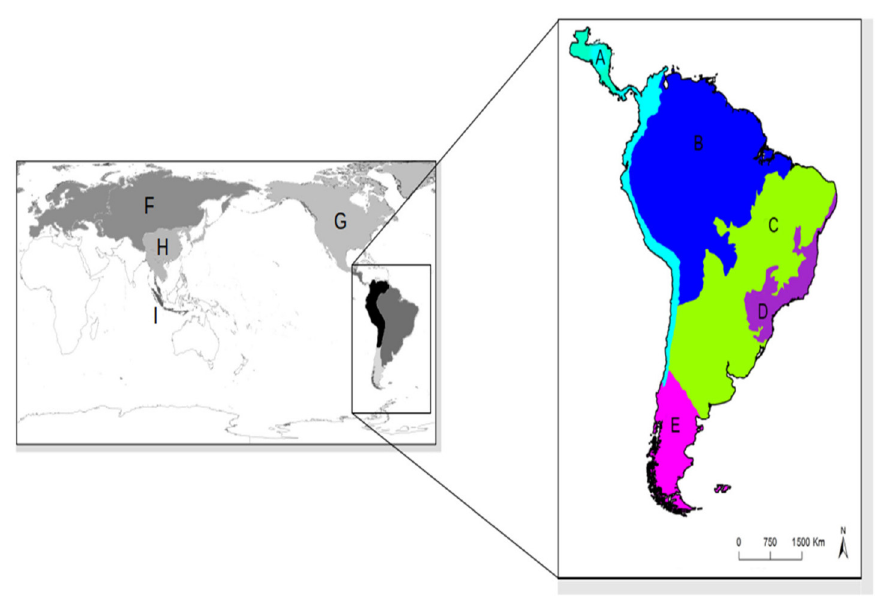
Figure 1. Map of world bumblebee species by region. Left: biogeographic regions of the world defined for bumblebees modified from Willians [7], and right: subdivisions of the Neotropical region modified from Morrone [45]. A—northern and western regions of the Andes (northwestern South America + South American Transition Zone [45]); B—Amazonian region; C—Chaco region; D—Parana region; E—Andean region; F—Palearctic region; G—Nearctic region; H—Oriental region; I–Sumatra region. The Sumatran region was not represented by any species in the